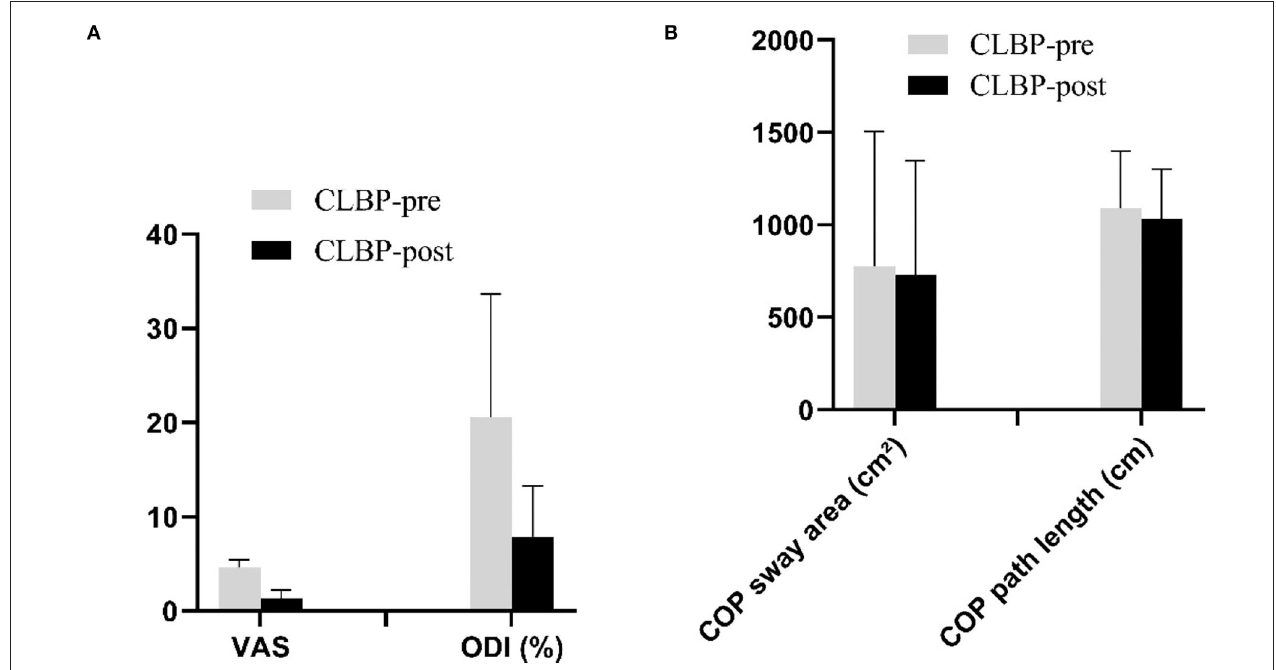
FIGURE 5 | (A,B) . The VAS, the ODI, and postural balance stability before and after intervention in the CLBP groups. CLBP, chronic low back pain; COP, center of pressure; ODI, Oswestry Disability Index; VAS, numerical pain rating scale.